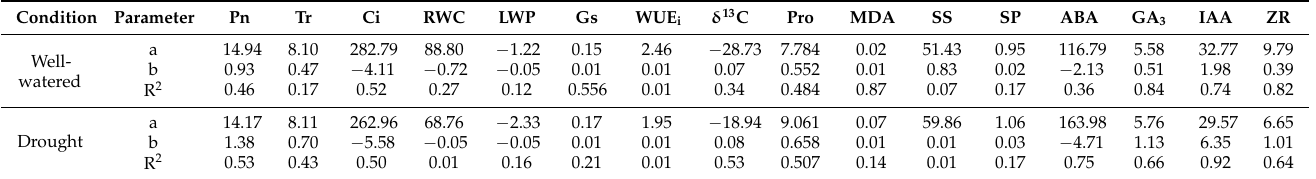
Table 3. Regression analysis of the photosynthetic water physiology, physiological, and biochemical characteristics of heteromorphic leaves and tree height under different soil moisture